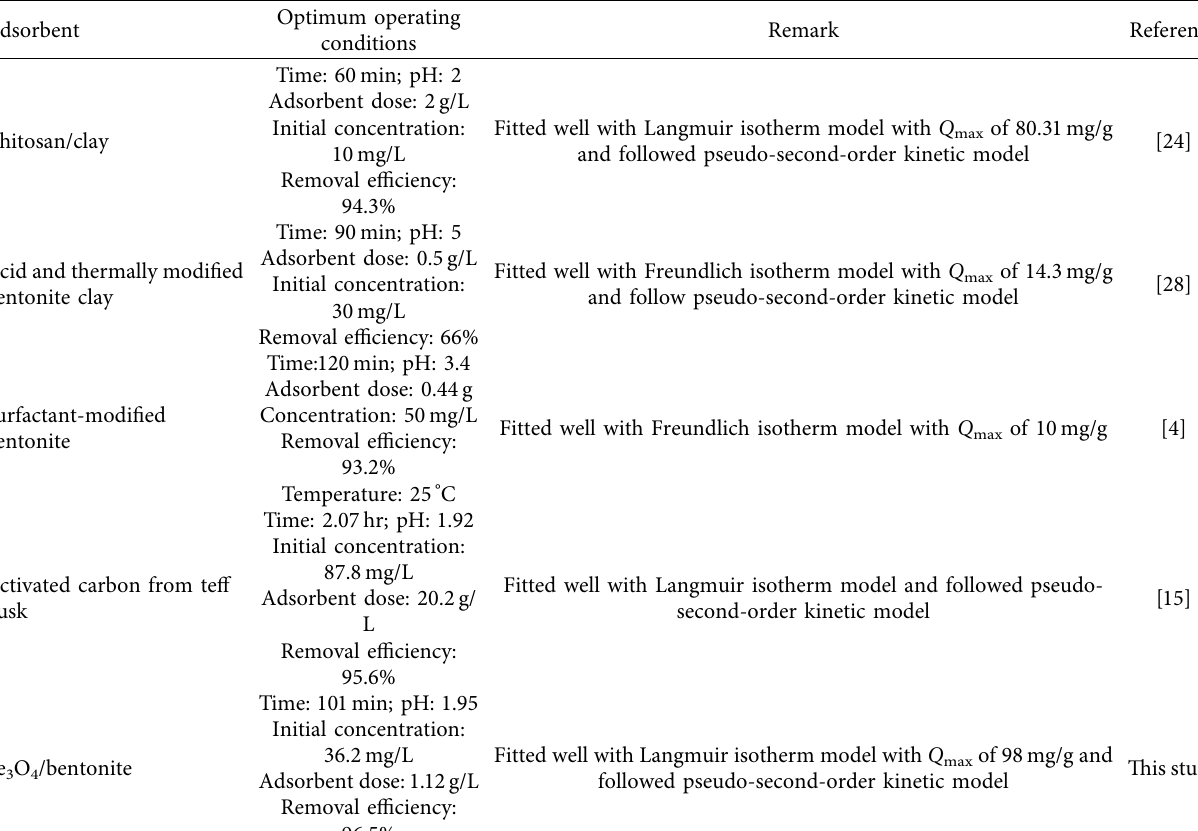
Table 10: Comparison of the maximum adsorption ( Q